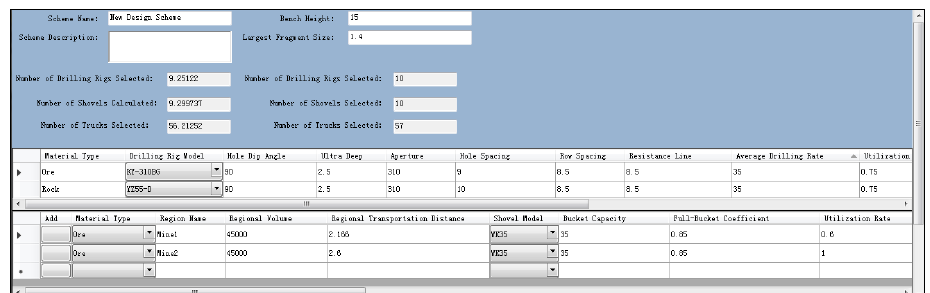
Figure 6. Output interface of equipment selection and matching results.